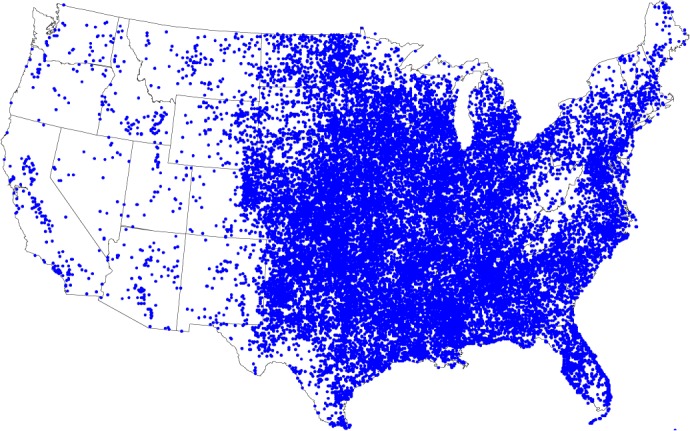
Geographic location of all reported tornadoes that occurred in the U.S., during the time period 1950–2013.